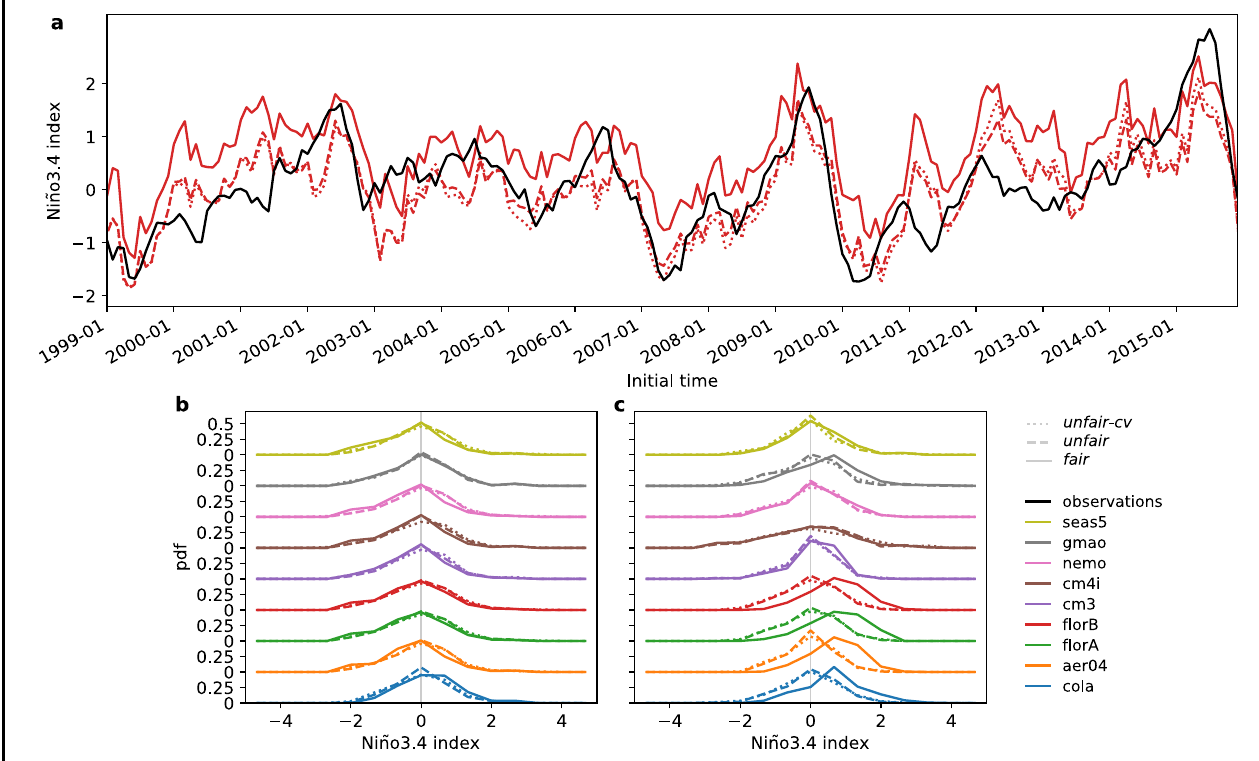
Fig. Box 3: Observed and model forecast Niño3.4 anomalies. In panel a the black line shows observed Niño3.4 anomalies in the testing period. The red lines are for the fl orB ensemble mean Niño3.4 anomalies at lead time 6 for anomalies calculated by the methods fair , unfair , and unfair - cv . The unfair - cv anomalies are calculated removing a 7-year cross-validation window. The probability density distribution of the anomalies is shown for each dynamical model over all months at lead time 0 * (panel b ) and lead 6 months (panel c ) in the testing period. The anomalies have been calculated according to the anomaly methods, fair (solid lines), unfair (dashed), and unfair - cv